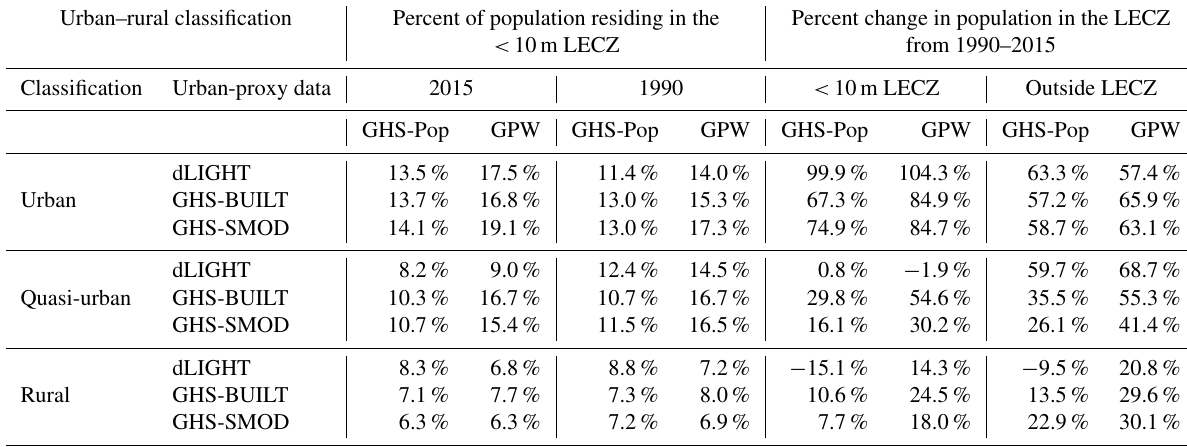
Table 7. Estimates of the global population and percentage change in the LECZ by urban–rural classes (based on different urban-proxy and population data sets) for